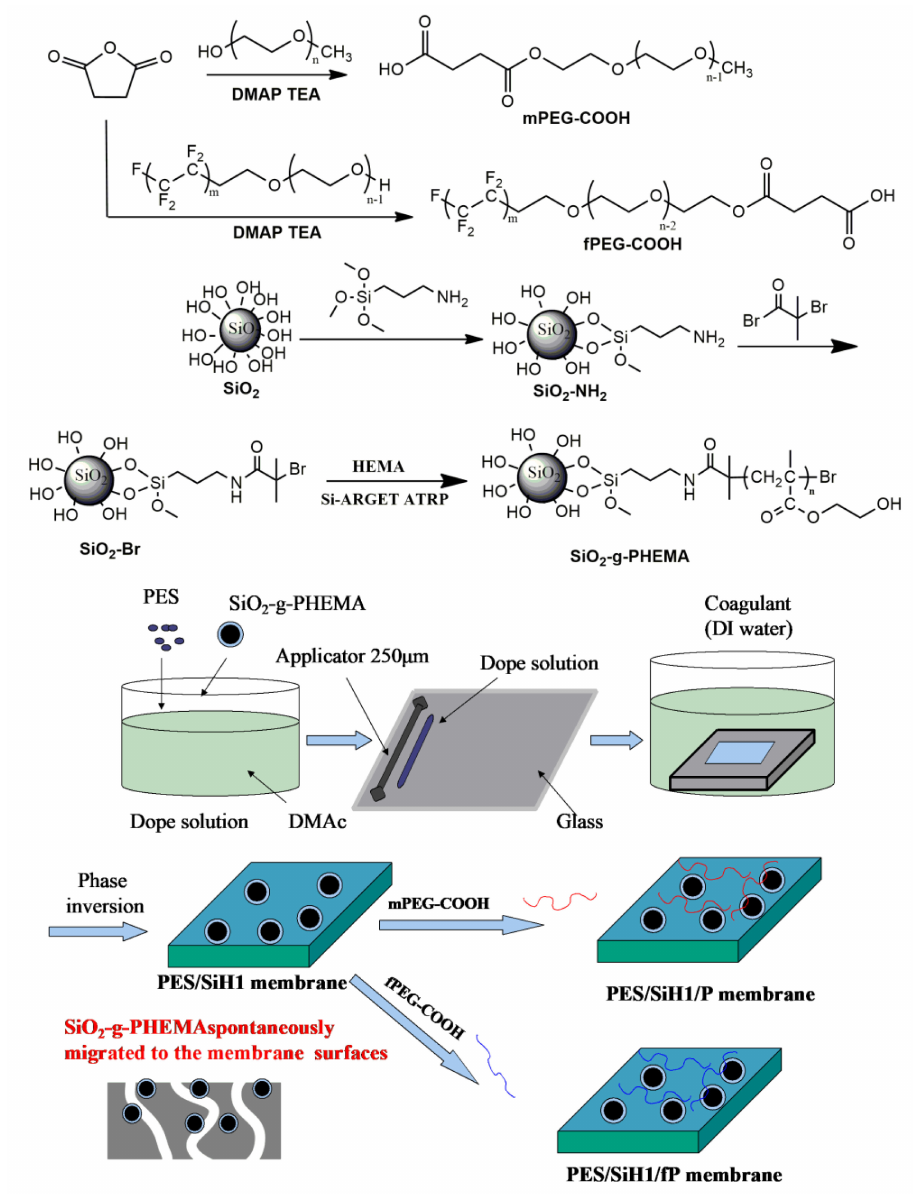
Figure 1. The preparation of the SiO 2 - g -PHEMA, fPEG-COOH, and PES/SiH1/fP